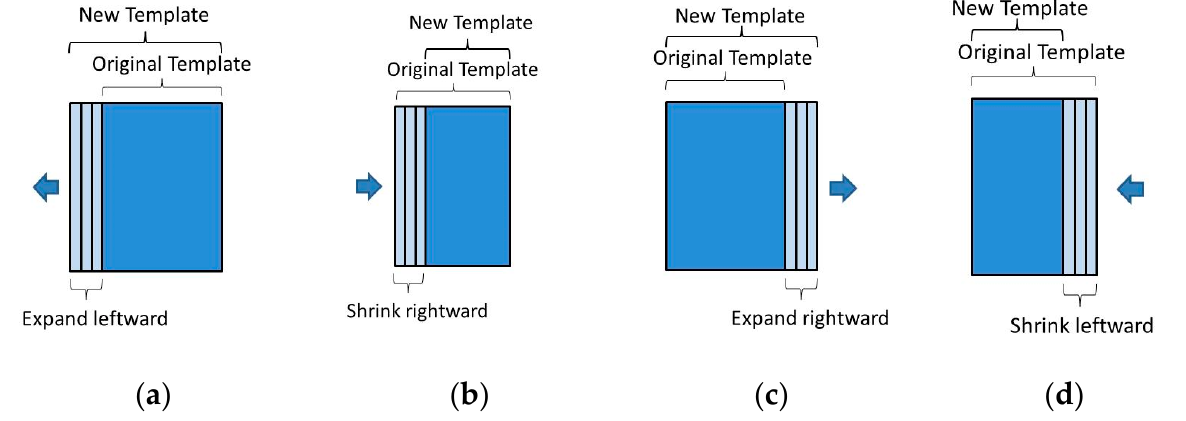
Figure 6. Adaptive adjustment of the left side and the right side of the template in the ADMTCF